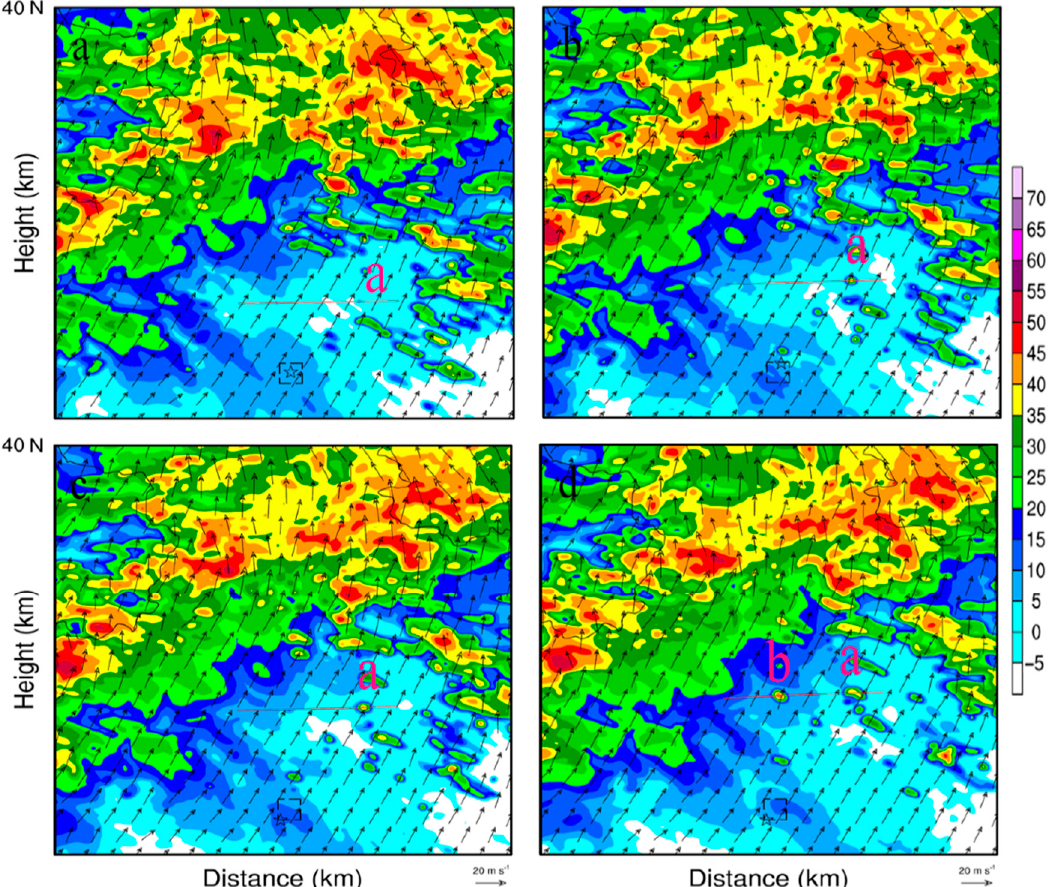
Figure 6. ( a – d ) Simulated composite radar reflectivity (shaded, unit: dBZ) and the wind field (vector arrows, units: m s − 1 ) at 700 hPa at 0438, 0450, 0456, and 0505 UTC 21 July 2012, respectively. The letters, “a” and “b” denote convective cells over the plains.